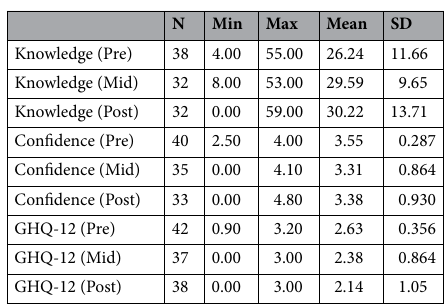
Table 10. The descriptive statistics of the scores of the Knowledge and Skill Questionnaire, and General Health